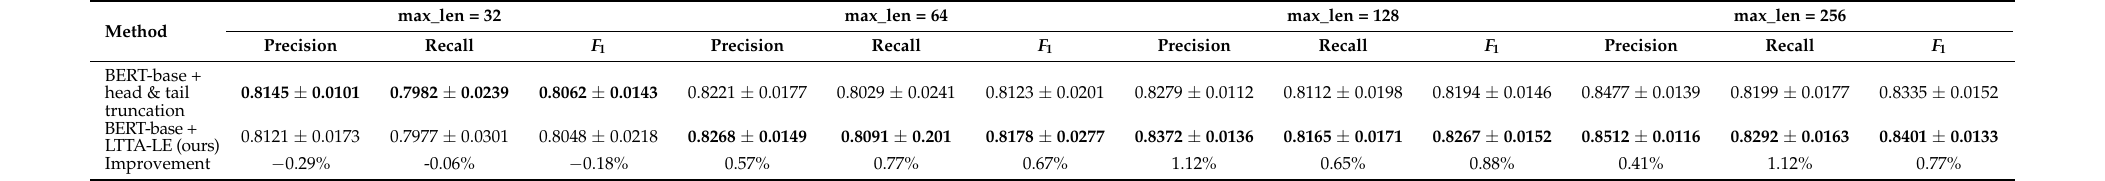
Table 3. Experimental results on the Arxiv dataset of different methods ( ± indicates standard